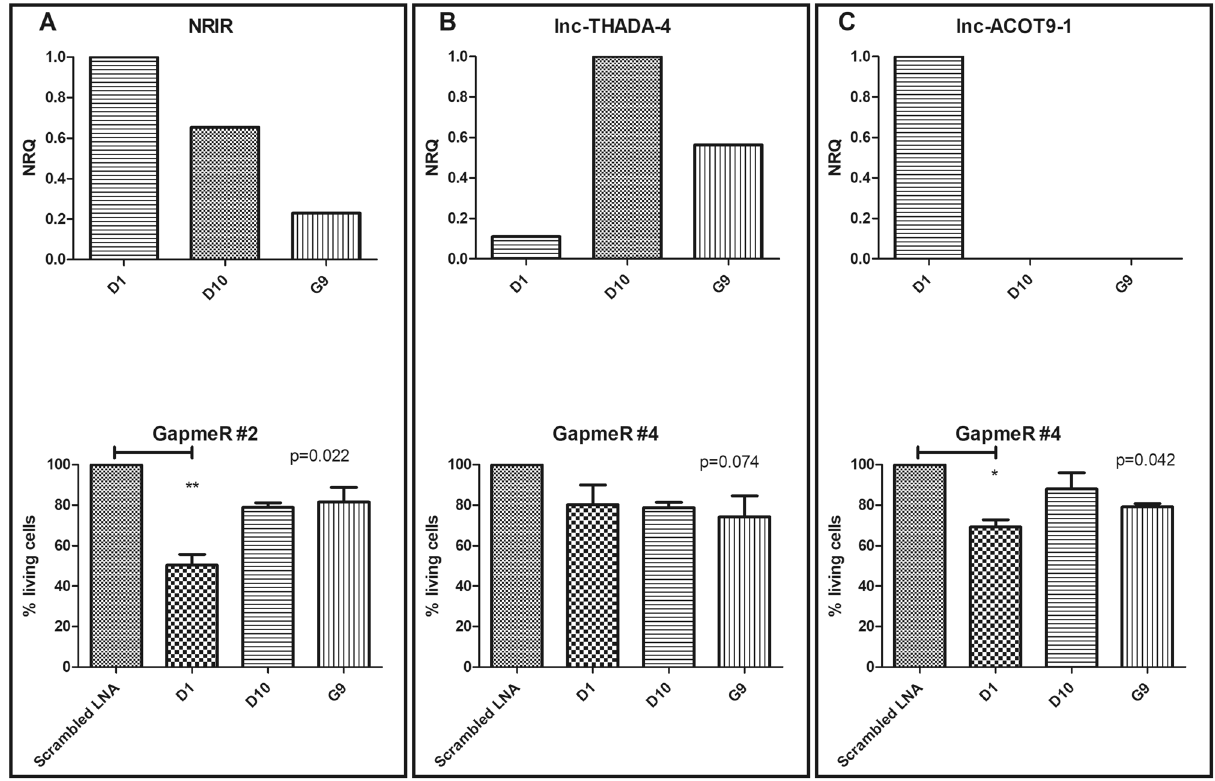
Figure 4. In vitro perturbation of lncRNAs in primary cultures of JMML MNCs. ( A – C ) GapmeRs against lncRNAs NRIR, lnc-THADA-4 and lnc-ACOT9-1 were in vitro evaluated in primary cultures of JMML MNCs (n = 3). Top: lncRNA expression was evaluated with qPCR in three primary cultures of JMML cells. Expression shown is relative to the average of three different housekeeping genes ( TBP , HPRT1 and GAPDH ) and rescaled against the primary culture with the highest expression. Bottom: evaluation of cell death after treatment of primary cultures with LNA GapmeRs against lnc-THADA-4 , lnc-ACOT9-1 and NRIR . Evaluation was performed after 72 h of incubation with 10 µM by co-staining for annexin V and 7-AAD followed by flow cytometric analysis. The graphs are an average of three technical replicates and show on the y-axis the percentage of cells alive normalized against primary cultures treated with scrambled LNAs (mean ± SEM). One-sided P values were calculated by one-way ANOVA with Bonferroni’s test and significance levels are indicated using asterisks. *P ≤ 0.05, **P ≤ 0.01. qPCR quantitative reverse transcriptase PCR, JMML juvenile myelomonocytic leukemia, MNCs mononuclear cells , lncRNA long non-coding RNA, SEM standard error of the mean , LNA locked nucleic acid, µM micro